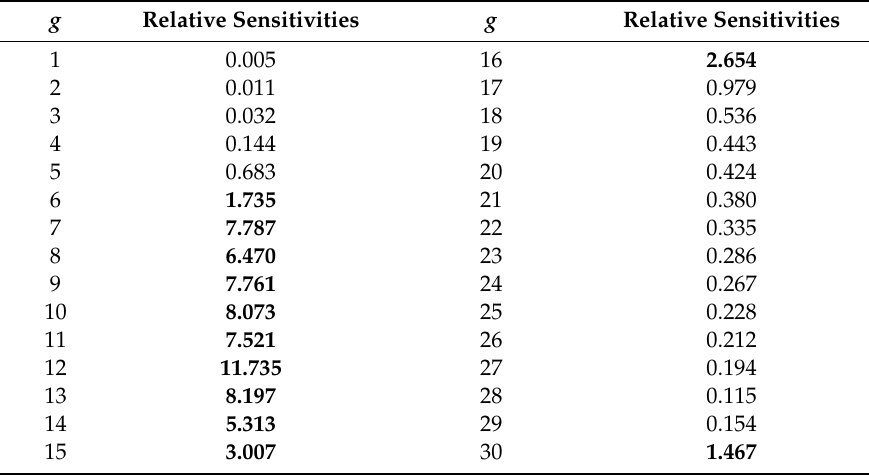
(cid:18) (cid:19) N 1,1 , σ g , g = 1, ... f ,1